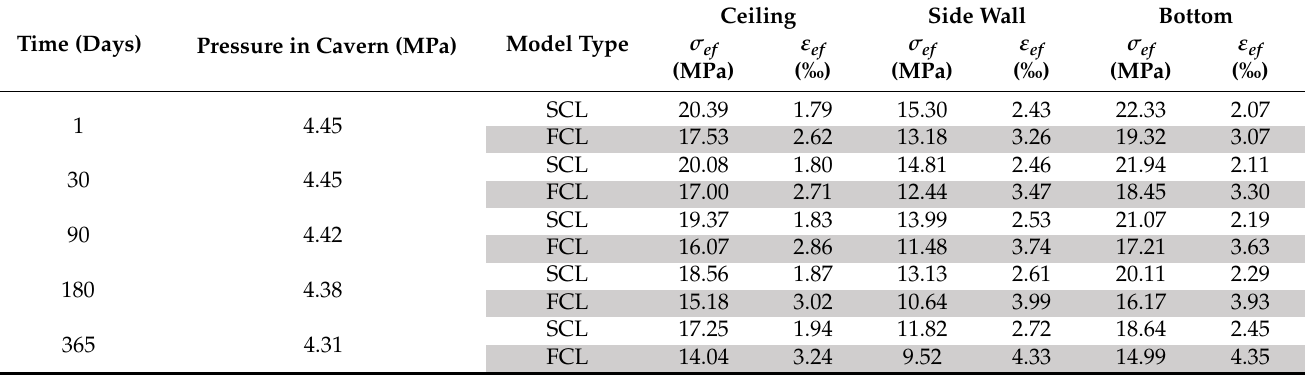
Table 6. Strength criteria for the two salt-creep models. Status at the end of a given downloading cycle (after emptying the cavern to the minimum